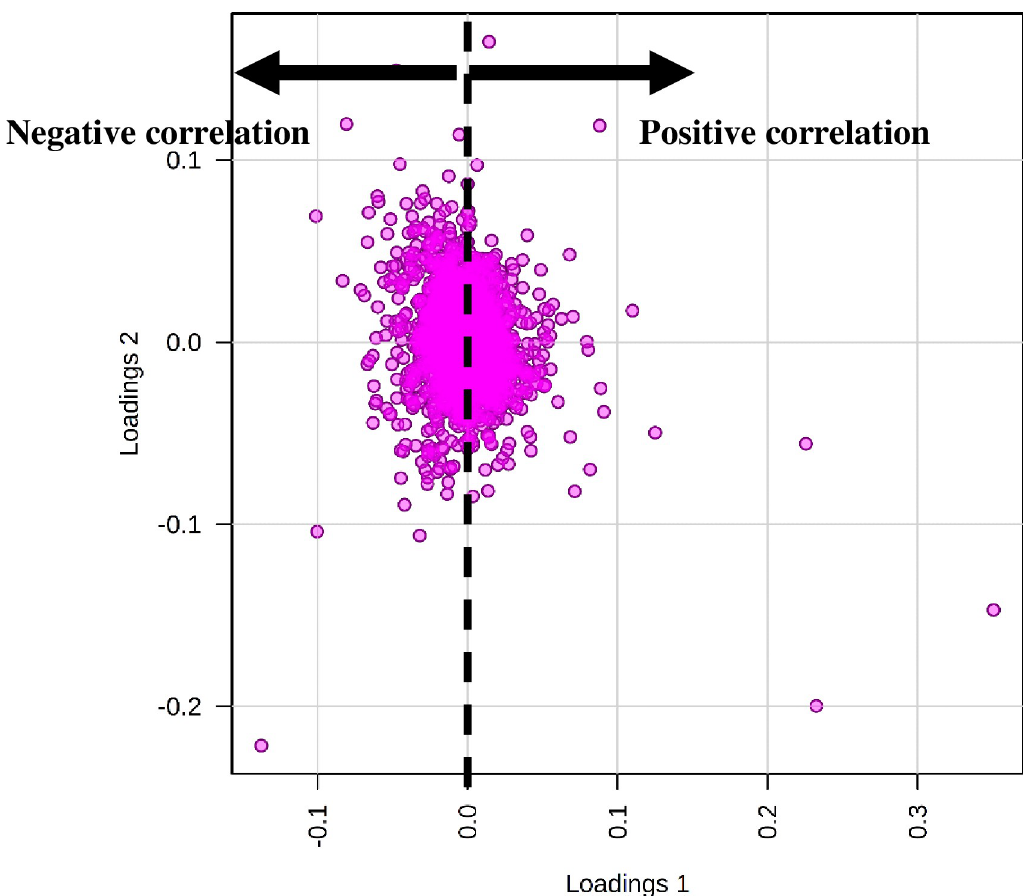
Fig 8. Loadings plot of two principal components from PLS-DA representing proteomics data from the evaluation of four different solubilization buffers. Majority peptides showed no significant difference for each buffer group.